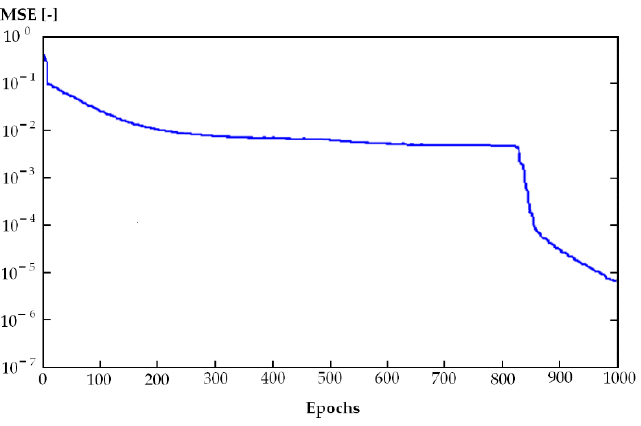
Figure 3. Values of mean square error (MSE) during learning (ANN1), x axis – number of